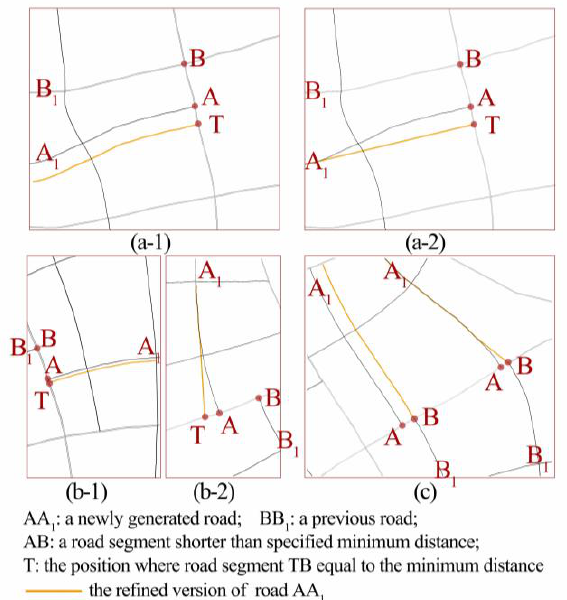
Figure 7. Ways to refine road